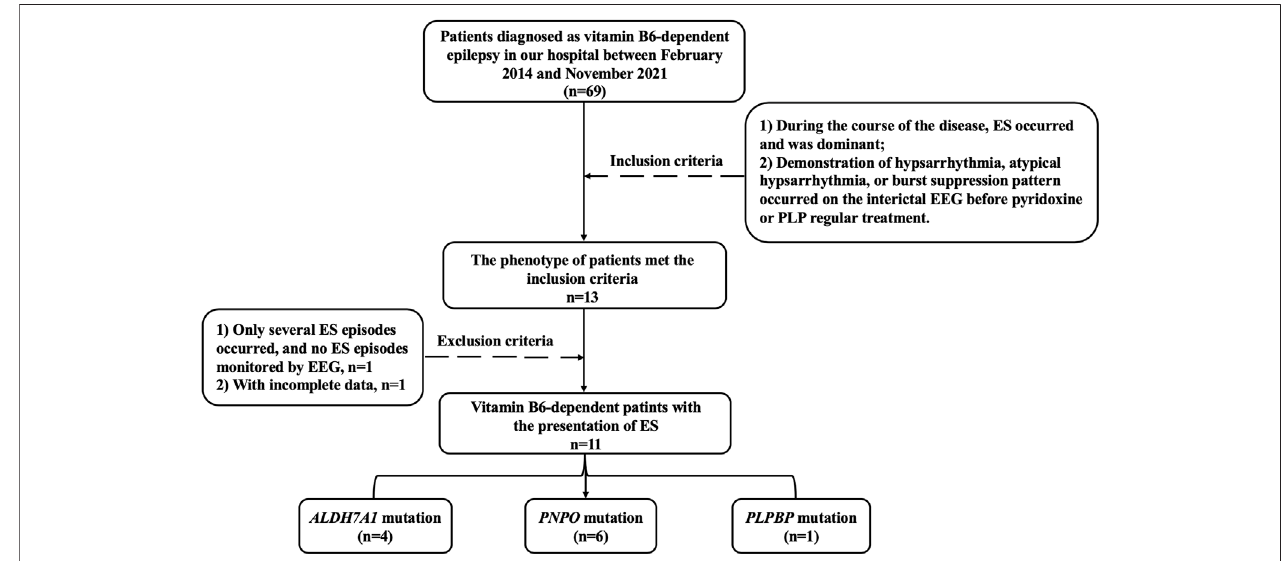
FIGURE 1 | Data screening fl ow chart. ES, epileptic spasms; EEG, electroencephalogram; PLP, pyridoxal-5 ′